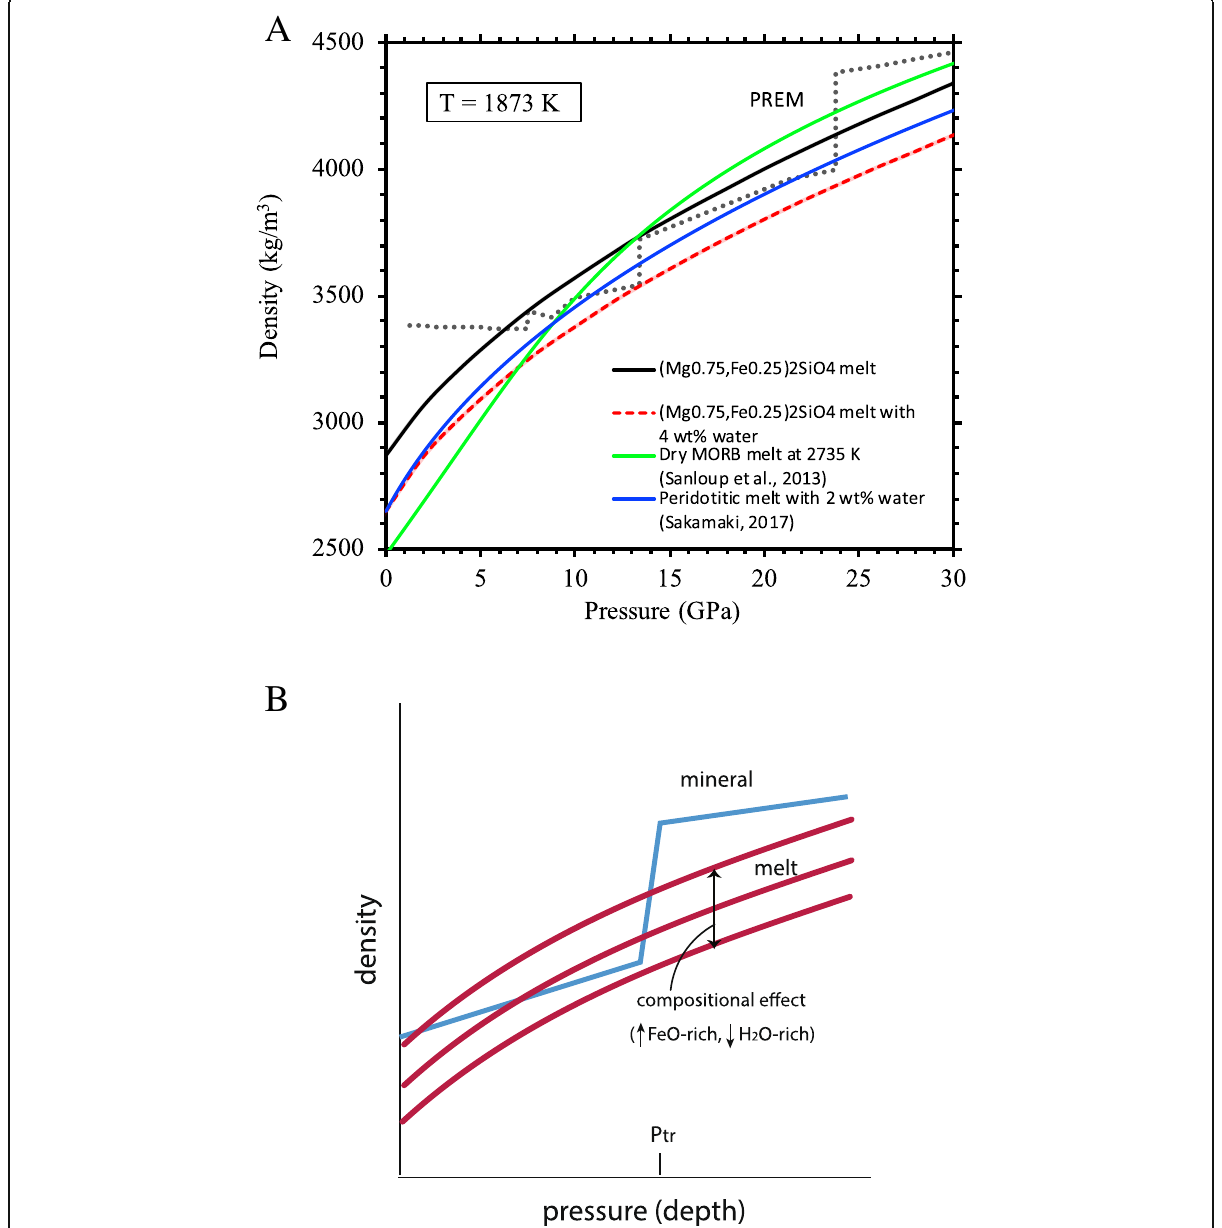
Fig. 4 The melt density across the mantle transition zone. a Melt density compared with the density of co-existing solids. The broken line shows the solid density. Black and red curves are the melt density based on the first-principles calculations of dry and hydrous (Mg 0.75 ,Fe 0.25 ) 2 SiO 4 melts (with hatched regions showing the influence of different compositions). A green curve is the density of dry MORB determined by (Sanloup et al. 2013) and a blue curve is the density of hydrous peridotite melt determined by (Sakamaki 2017) from high-pressure experiments. The gray region shows the effects of a change in FeO content by ± 5%, and the pink region shows the effects of water by ± 2 wt.%. b A s chematic diagram showing how density of melt and solid changes across a phase transformation. Structural change in a solid is abrupt, but it is gradual in a melt. This leads to higher density of a melt than a solid above the transition pressure, but below the transition pressure, melt density tends to be lighter than the solid